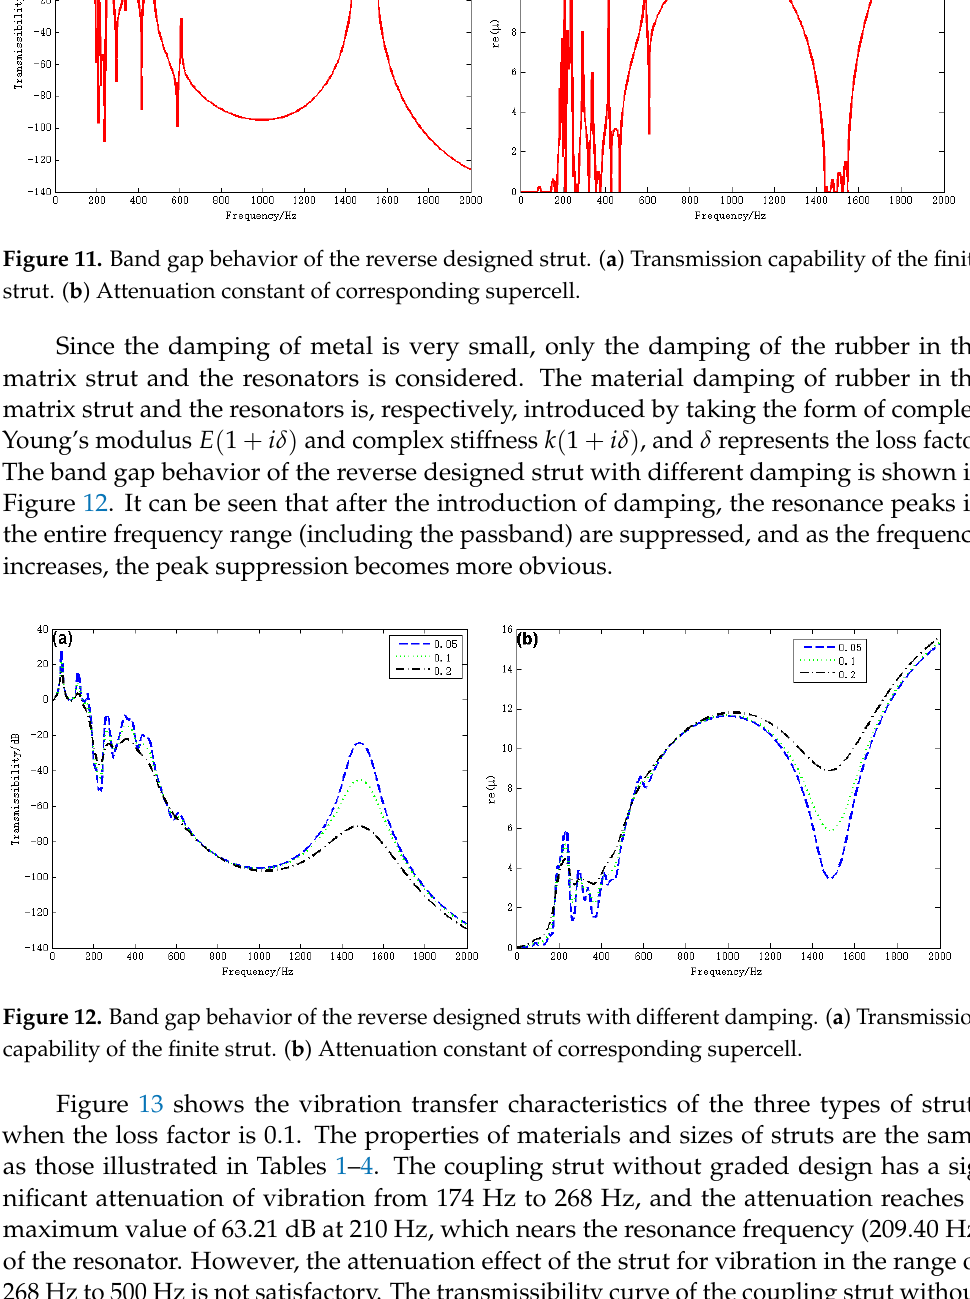
Table 4. Calculated parameters of the resonators in each cell.